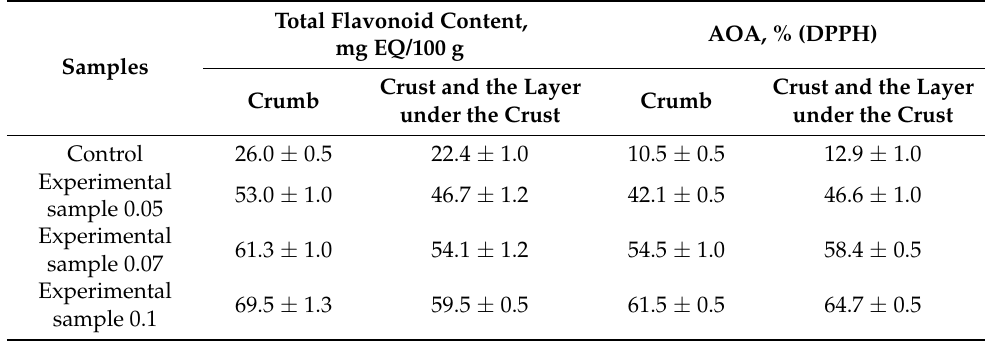
AOA, % (DPPH) Crust and the Layer Crumb under the